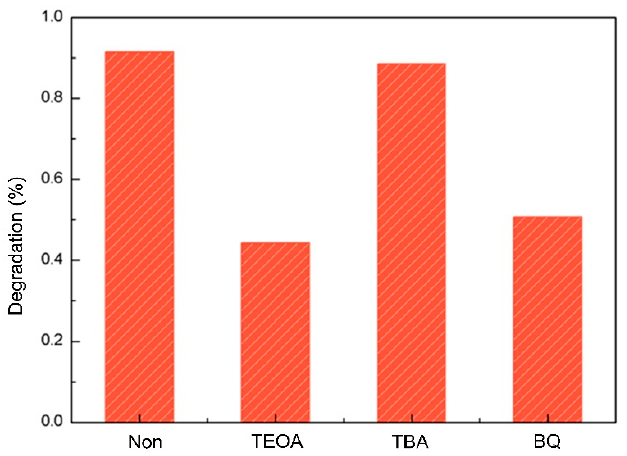
Figure 11. Trapping experiment of active species during the photocatalytic degradation of TC over 0. 4 Ni/Ti-Bi 2 WO 6 photocatalyst under visible-light irradiation.